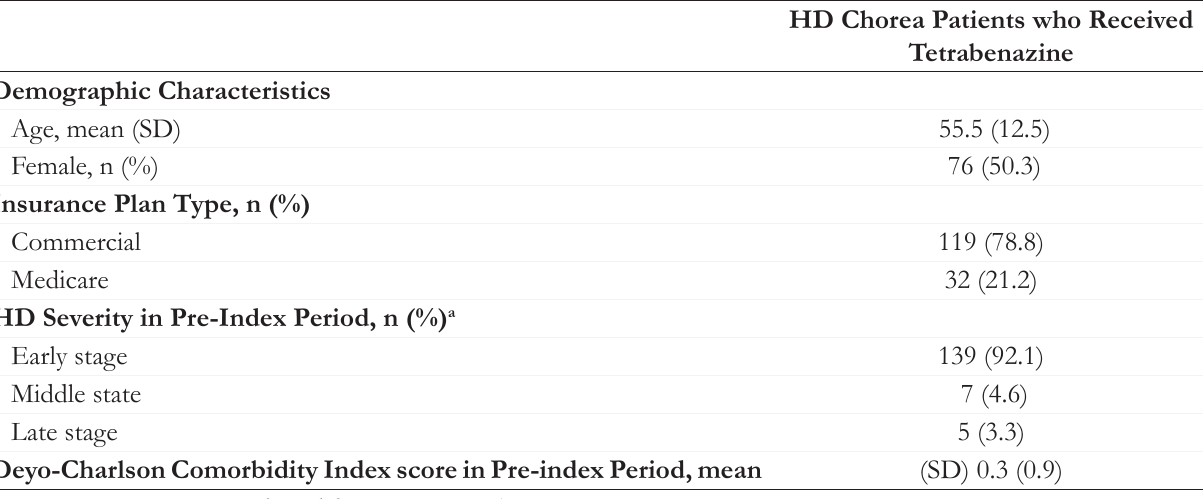
Table 1. Baseline Demographic and 6 Month Pre-diagnosis Clinical Characteristics of